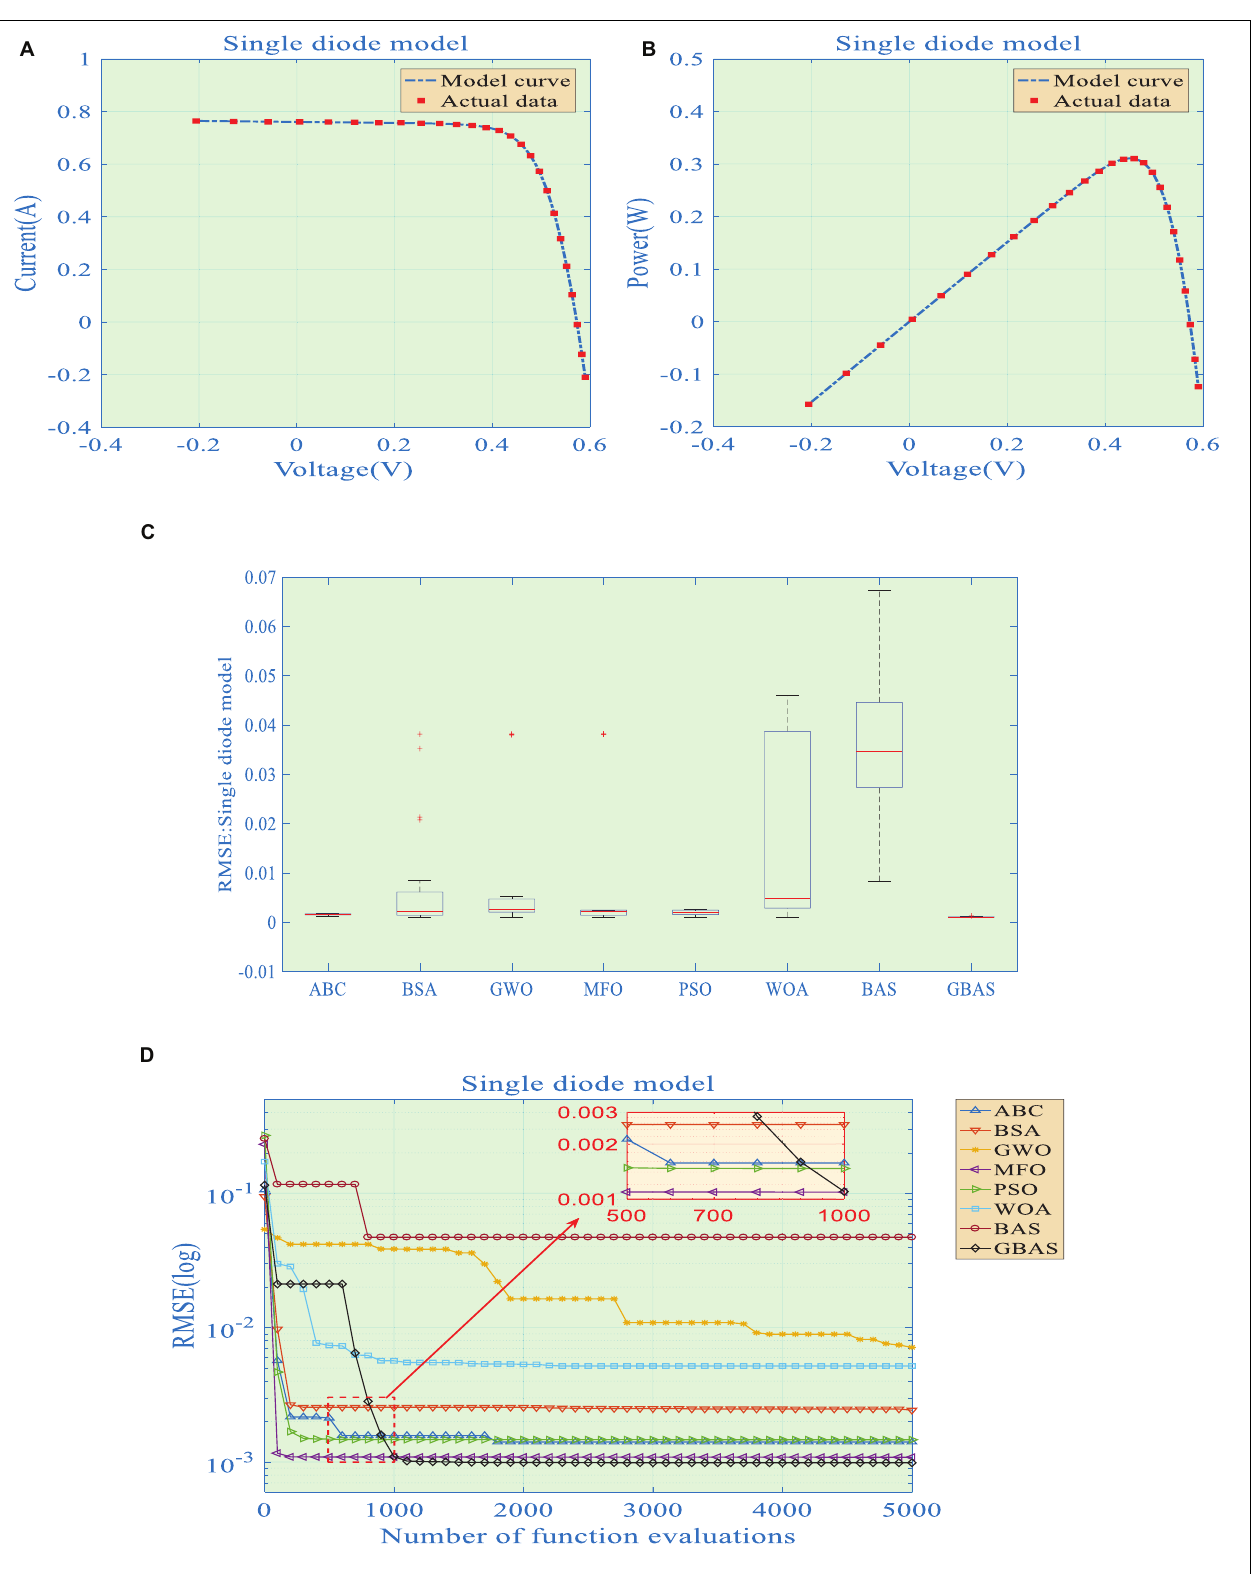
FIGURE 2 | Identification results obtained by grouped beetle antennae search (GBAS) algorithm for SDM: (A) I-V curve; (B) P-V curve; (C) boxplot of RMSE; (D) convergence graph.